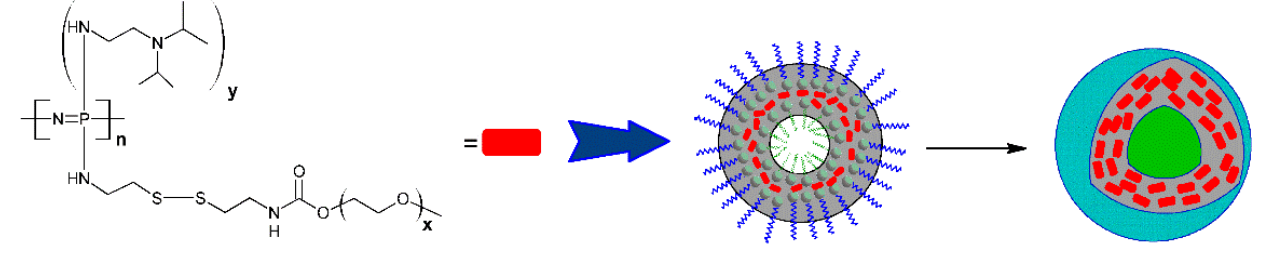
Figure 14. Polyphosphazene-based polymersomes.